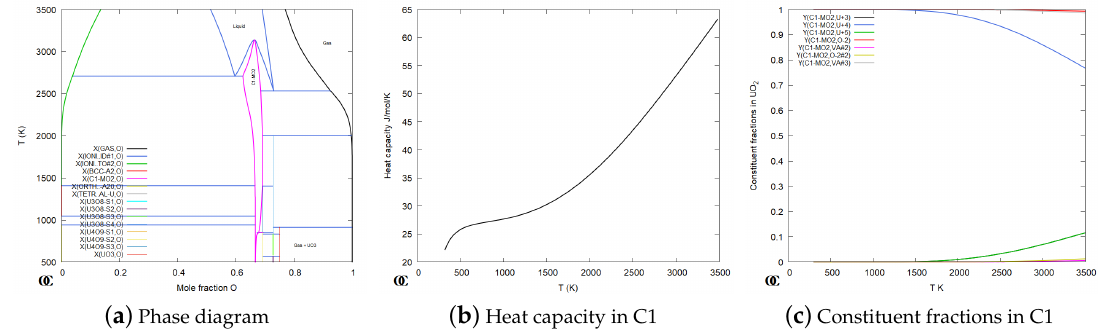
Figure 7. ( a ) The phase diagram for the U-O system, ( b ) the heat capacity (with a significant contribution from the configurational entropy) and ( c ) the constituent fractions in C1 at ideal stoichiometry as a function of T .